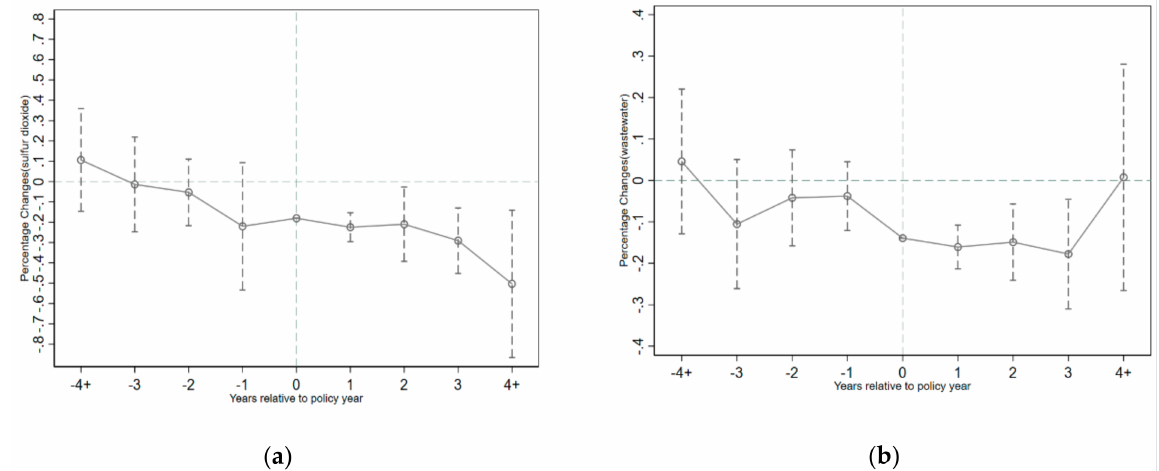
Figure 3. The dynamic effect of policy on the pollution emissions. Note: ( a , b ) plot the impact of this policy on the logarithm of the industrial SO 2 and wastewater emissions, respectively. The dashed lines represent 95% confidence intervals, adjusted for city-level